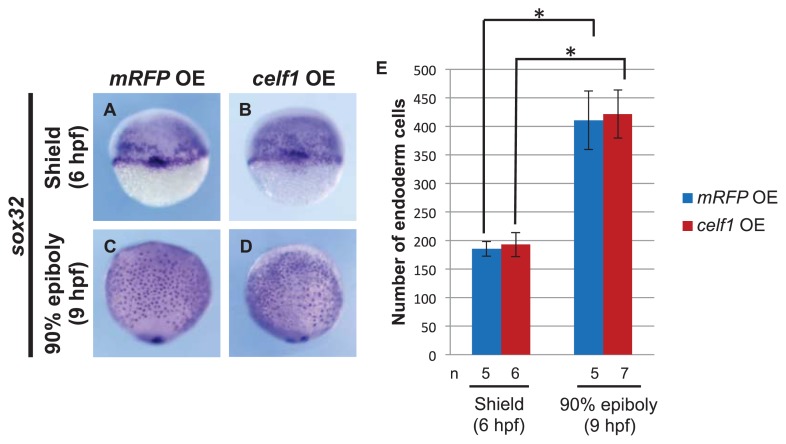
Effect of celf1 overexpression on endoderm proliferation. (A–D) sox32 expression in endoderm cells at 6 (A,B) and 9 hpf (C,D) in mRFP OE (A,C) and celf1 OE embryos (B,D). Anterior to the top. (E) Overexpression of celf1 did not affect endoderm proliferation. Asterisks indicate statistically significant differences (* p < 0.05).